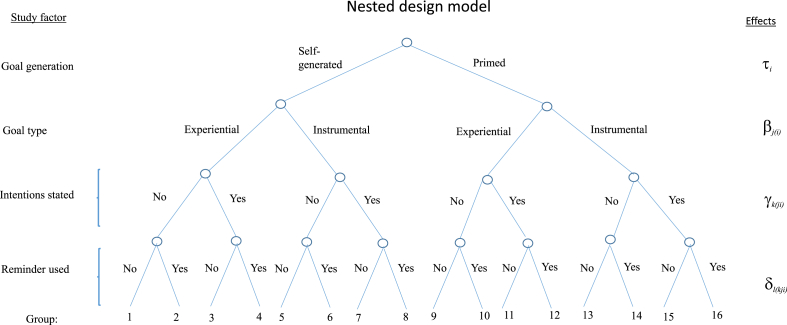
Schematic illustration of the study design.